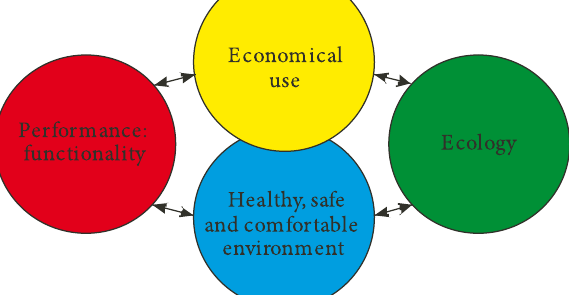
They may be grouped for analytical purposes as fol- lows: functional efficiency, the adaptation of the road to the activities for which it is to be used; durability, the physical qualities of the road, which determine, how long the road can continue to ren- der useful services;